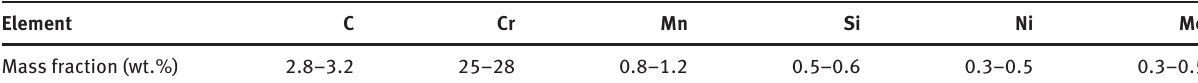
Table 4: Chemical composition of HCCI. Element Mass fraction (wt.%)